Question: What form of chart is displayed?
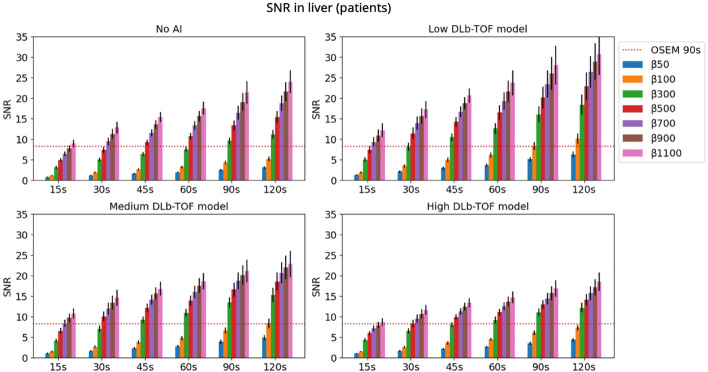
Answer: bar